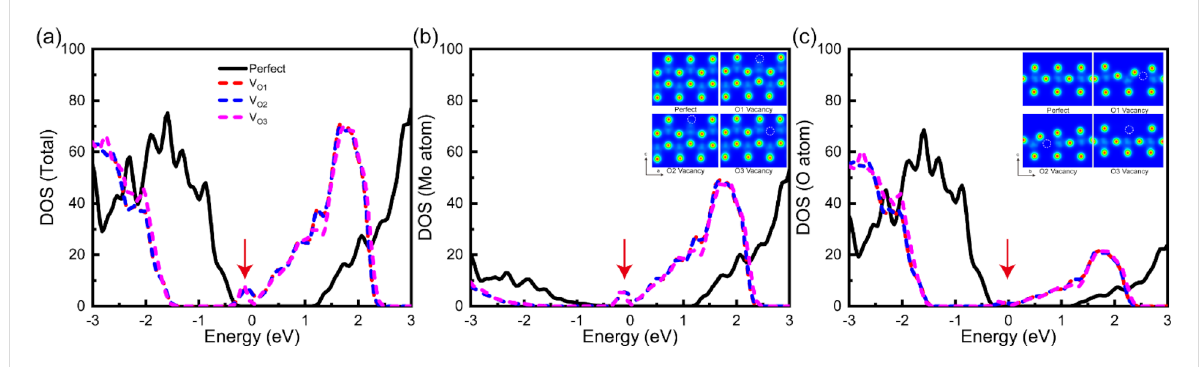
Figure 4: Calculated (a) total electronic density of states (DOS) and projected DOS for (b) Mo and (c) O atoms of the MoO 3 monolayer. The insets of (b) and (c) show the total charge density from different views.